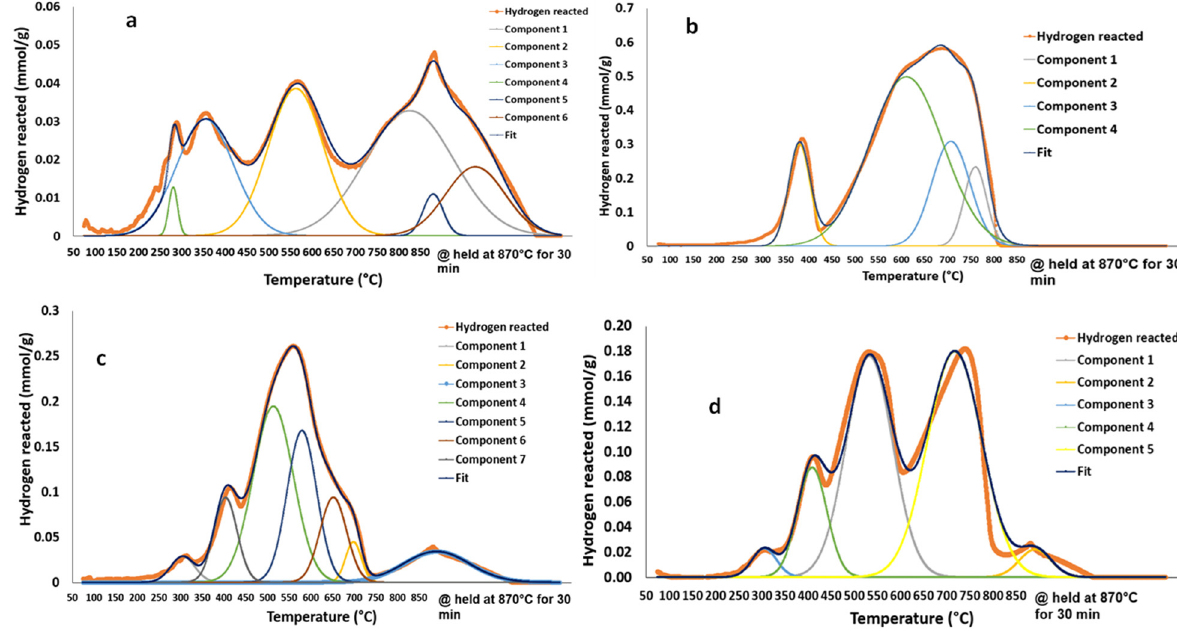
Figure 8. H 2 -TPR spectra recorded with LSF-perovskite ( a ), Fe 2 O 3 ( b ), CS-4 ( c ), CS-5 ( d ). Table 4. H 2 -TPR peaks positions, total amount of hydrogen and oxygen reacted.